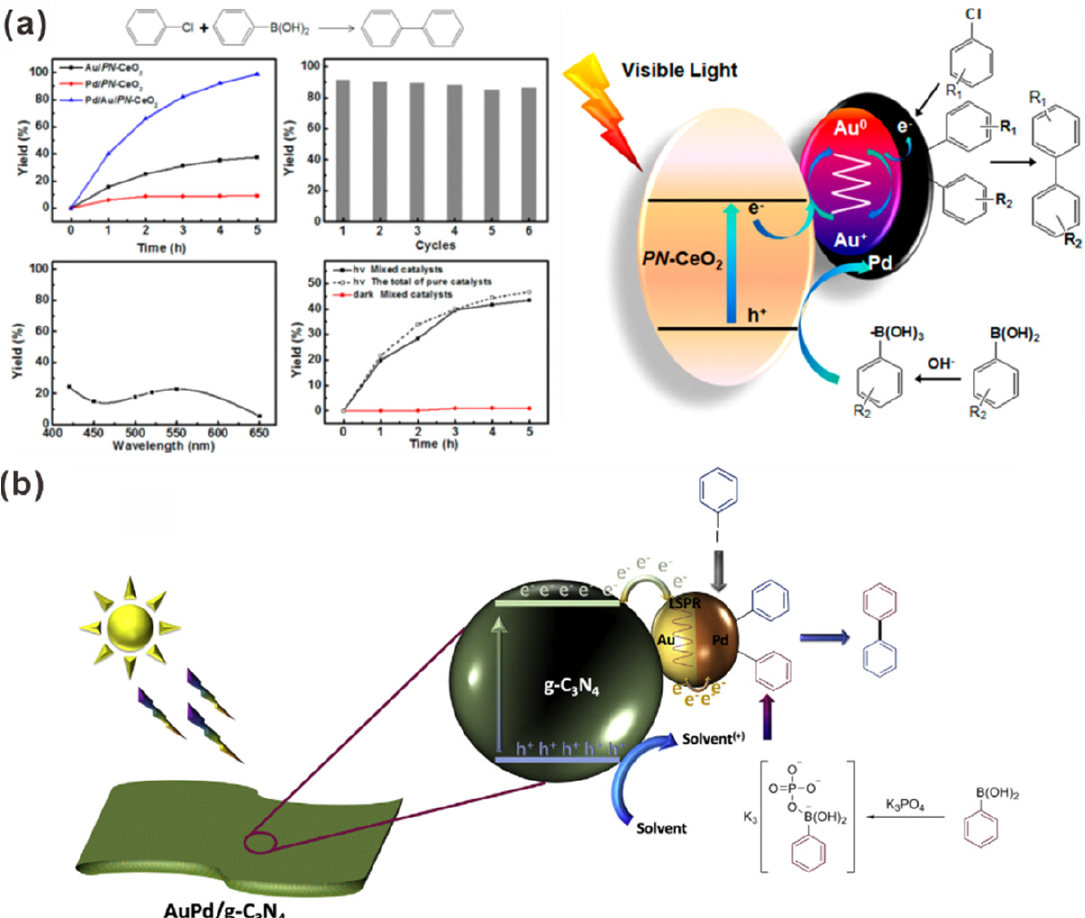
Figure 9. AuPd NPs decorated semiconductors for photocatalytic Suzuki coupling under visible light. ( a ) Pd/Au/CeO 2 . Reproduced with permission from Reference [104]. Copyright 2015 American Chemical Society. ( b ) AuPd/g-C 3 N 4 . Reproduced with permission from Reference [105]. Copyright 2020 Elsevier.